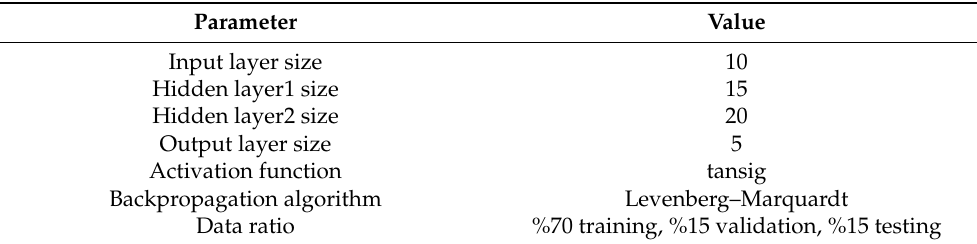
Table 2. ANN model properties.